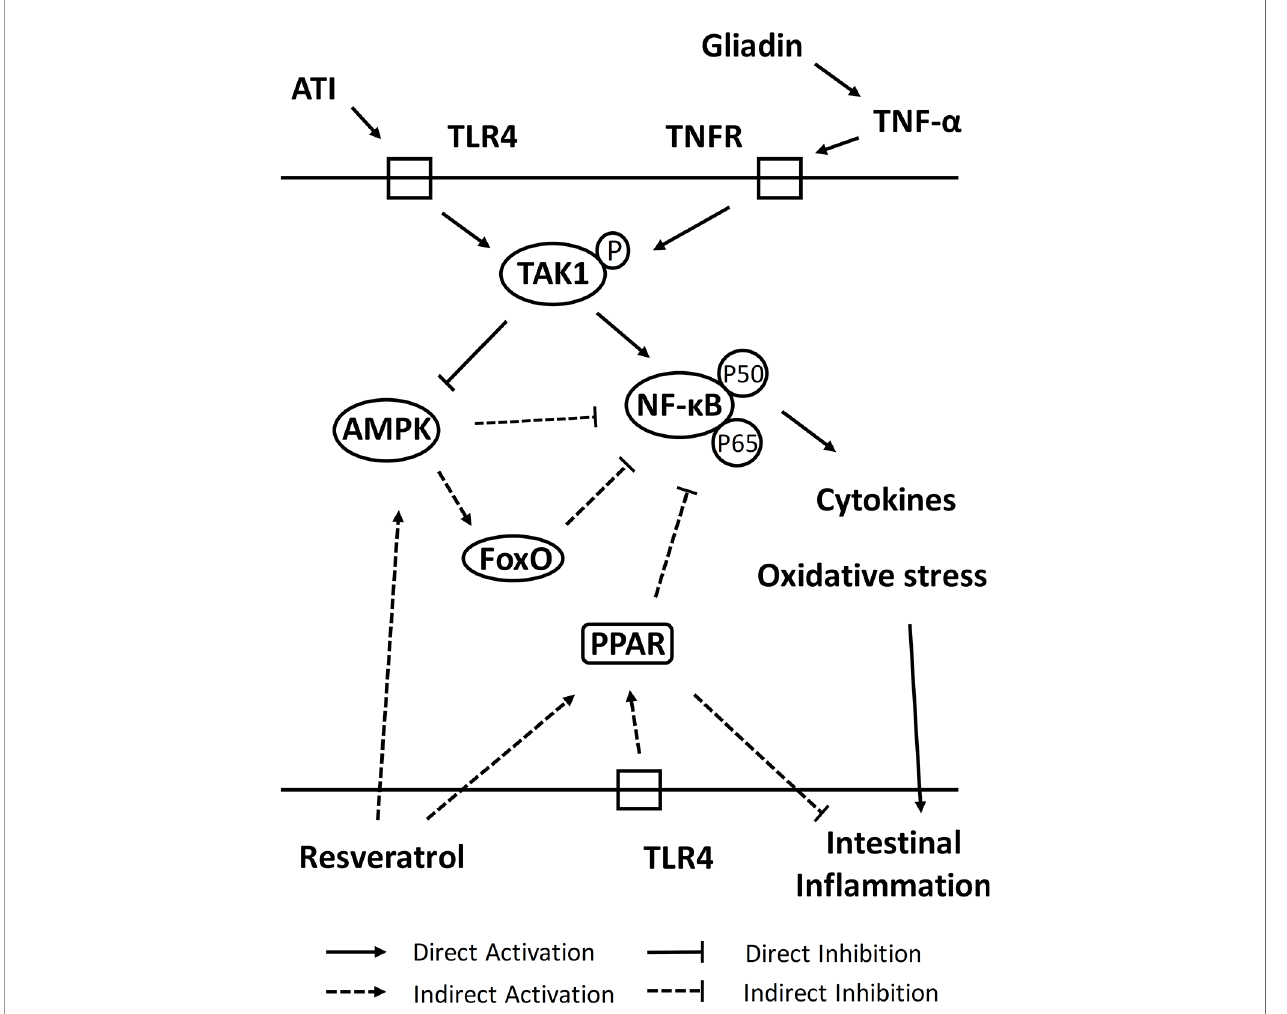
FIGURE 7 | The mechanism of resveratrol intervention on intestinal damage of celiac